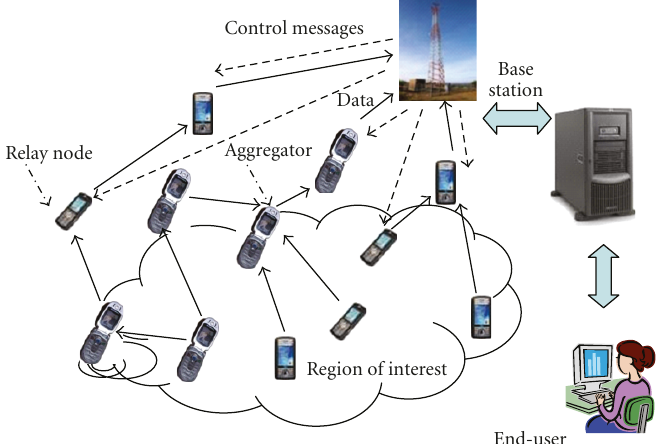
Figure 1: Schematic of a Multihop Cellular Sensor